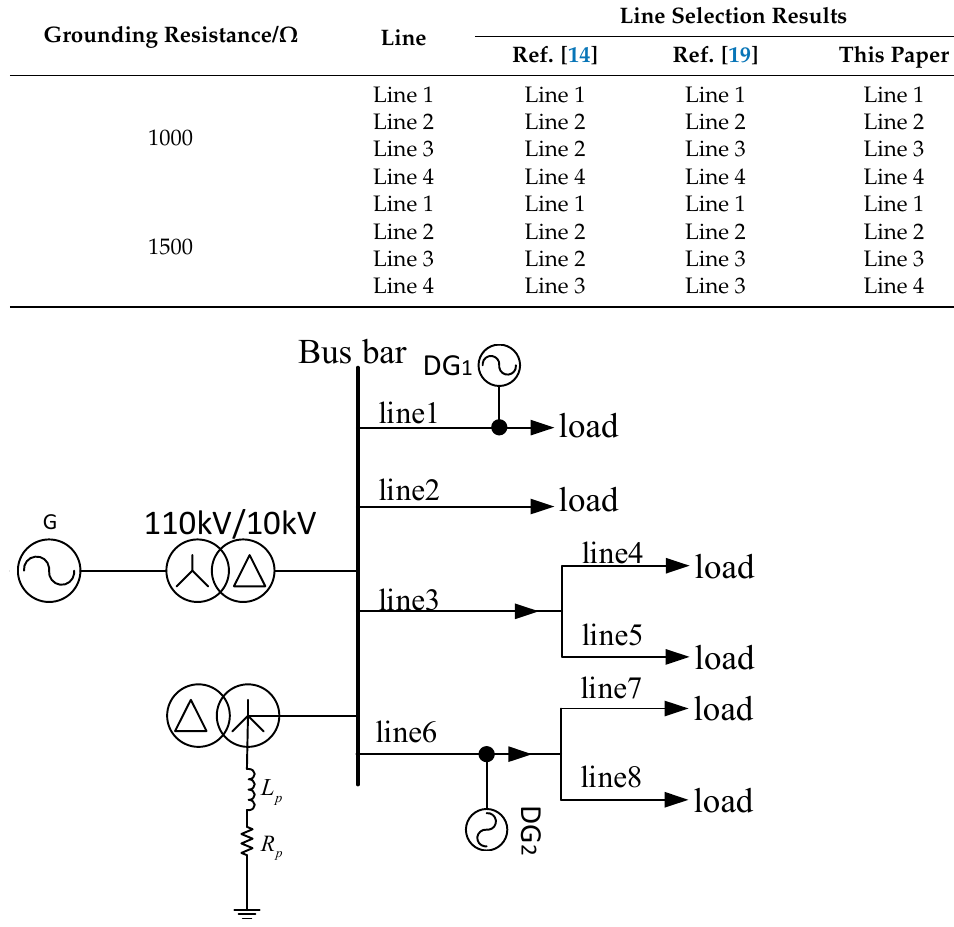
Figure 21. Distribution network with distributed generators.